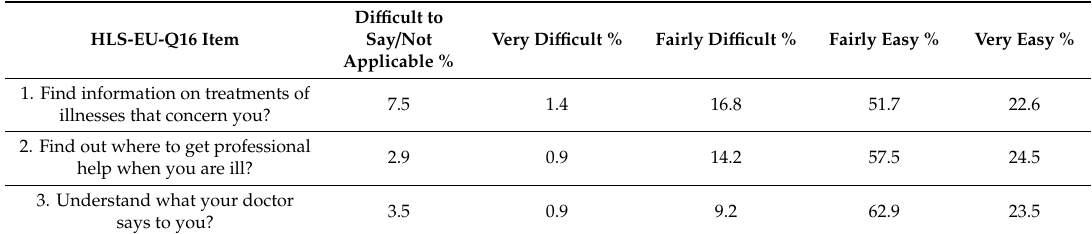
Table 1. The distribution of responses to individual items included in the European Health Literacy Project (HLS-EU)-Q16